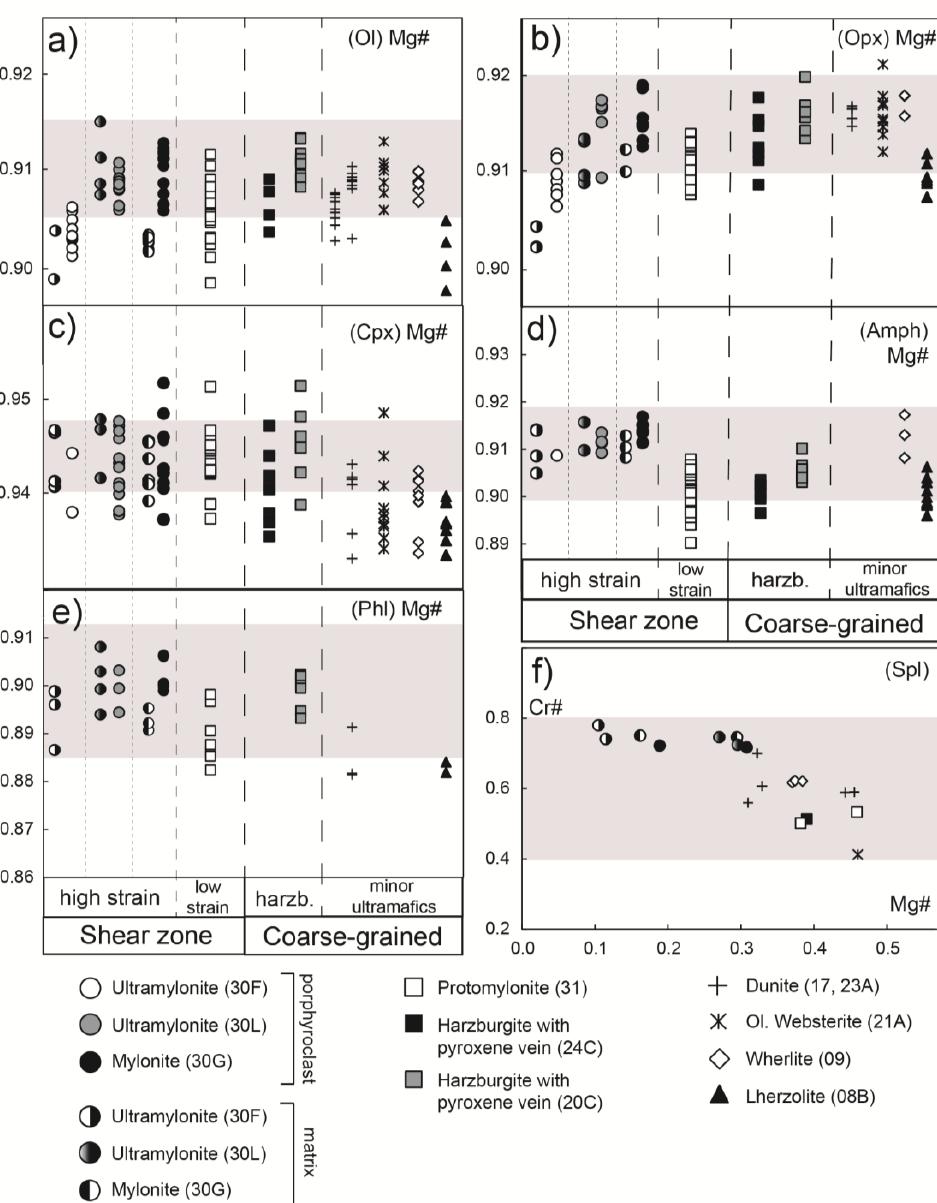
Figure 5. Major element ratios based on EMPA analyses of mineral phases of Finero Ph-Pd samples: Mg# in ( a ) olivine; ( b ) orthopyroxene; ( c ) clinopyroxene; ( d ) amphibole; ( e ) phlogopite; ( f ) Mg# (on x axis) vs Cr# (on y-axis) in Cr-spinel. The grey band refers to the range from literature data [1,15,17] on comparable Finero Ph-Pd samples.